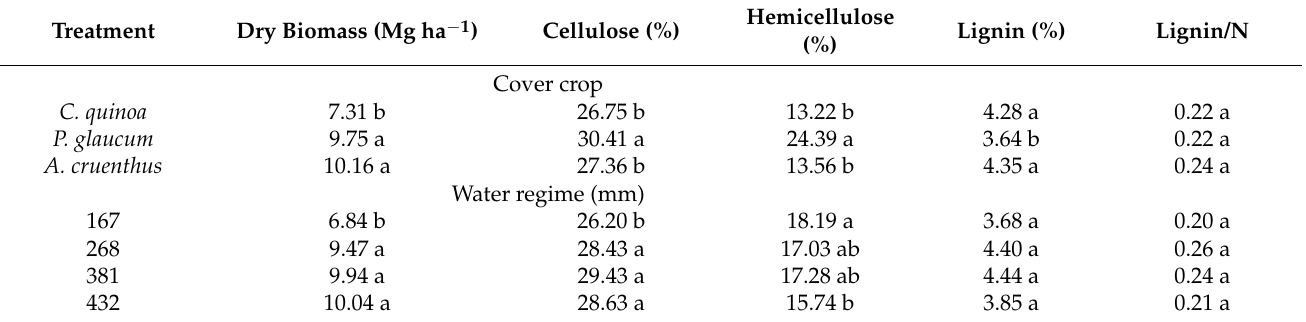
Table 2. Dry biomass (BS) and contents of cellulose, hemicellulose, lignin and lignin/N ratio in the cover crops ( A. cruenthus, P. glaucum and C. quinoa ) and in the water regimes (167, 268, 381 and 432